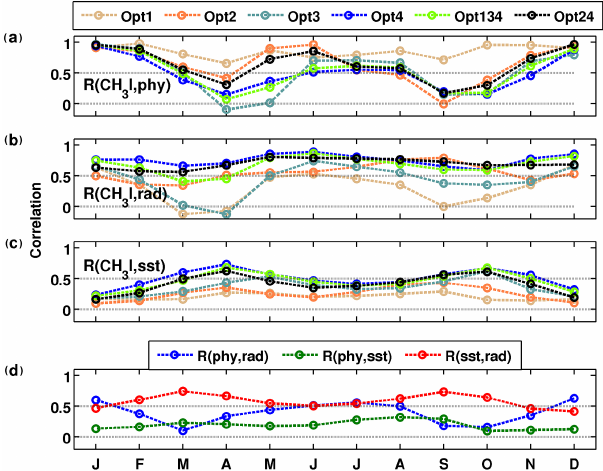
Figure 11. Spatial correlation of the monthly methyl iodide surface concentrations along the 30 ◦ W meridian (60 ◦ N–60 ◦ S), with sur- face phytoplankton concentrations (a) , radiation (b) and sea surface temperature (c) , and spatial correlations of phytoplankton and radi- ation ( R (phy,rad)), phytoplankton and SST ( R (phy,sst)), and SST and radiation ( R (sst,rad)) (d) . All correlations are significant on the 95%